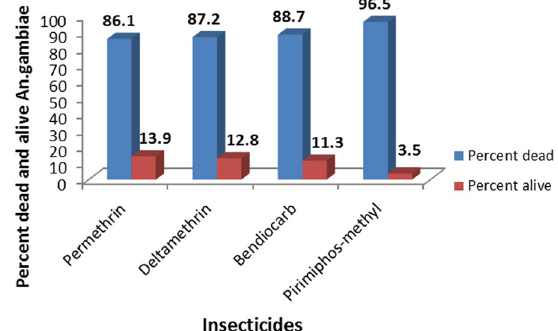
Fig. 3 Percent of dead and resistant mosquitoes by different insecticides